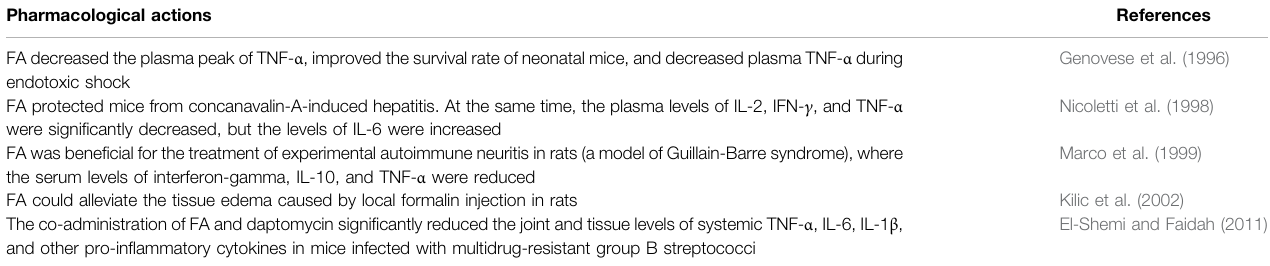
TABLE 1 | Experiments show that FA modulates immunity and the in fl ammatory process.